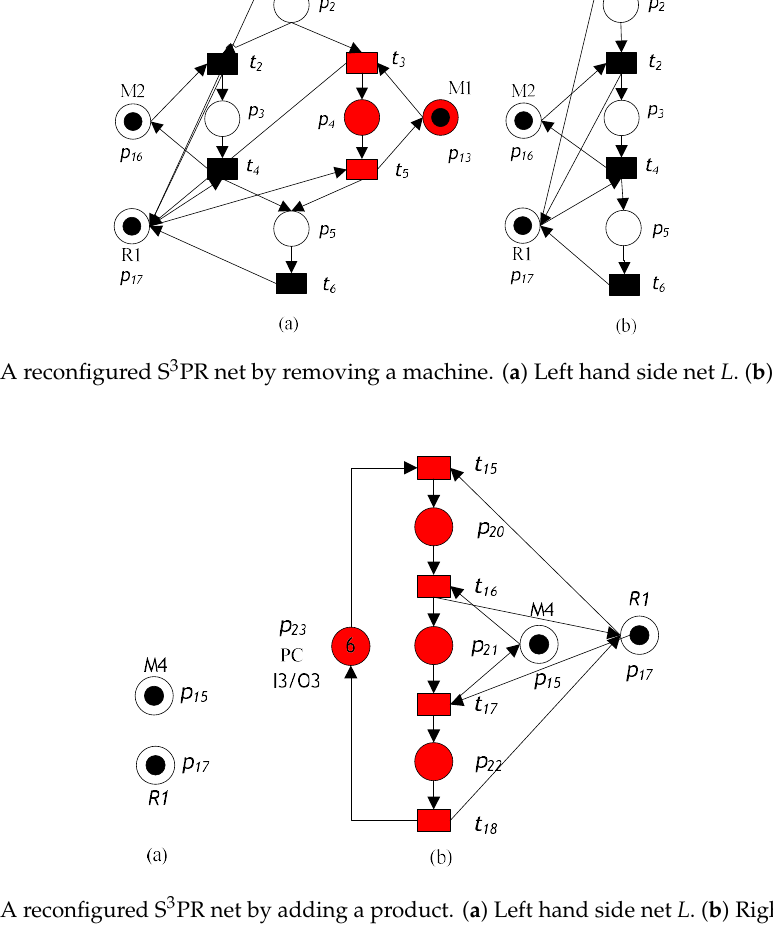
Figure 18. A reconfigured S 3 PR net by adding a product. ( a ) Left hand side net L . ( b ) Right hand side net R .